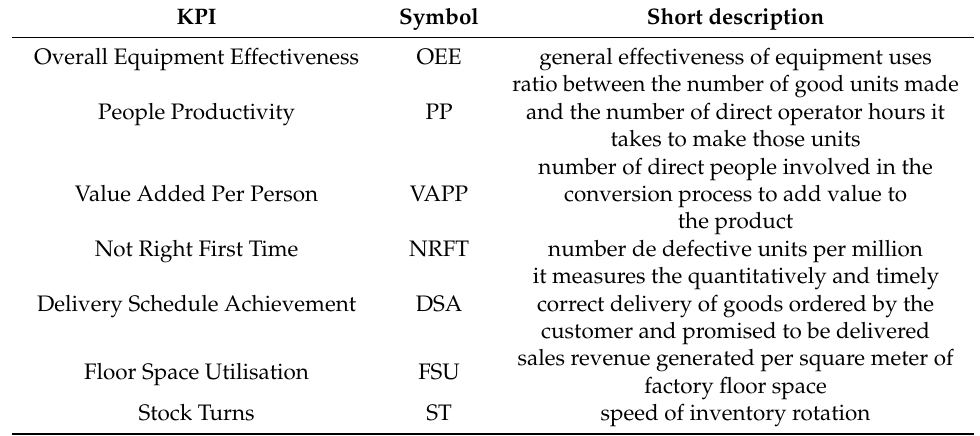
Table 1. Evaluation of Lean performance using KPI, KPI: key performance indicators.